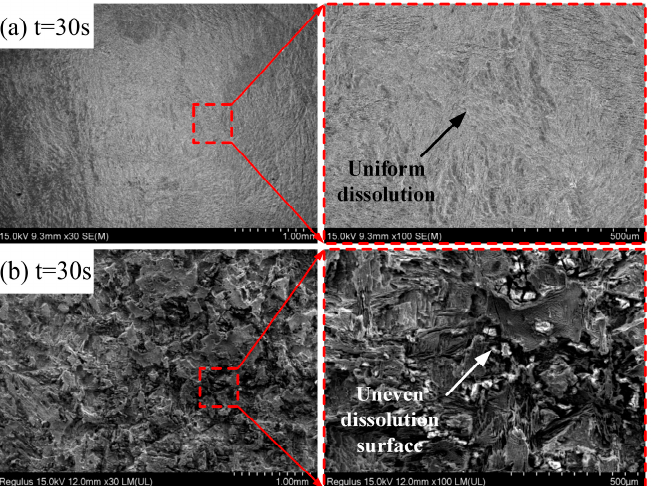
Figure 15. ( a ) ECFAP with U = 35 V for 30 s; ( b ) ECP with U = 35 V for 30 s.